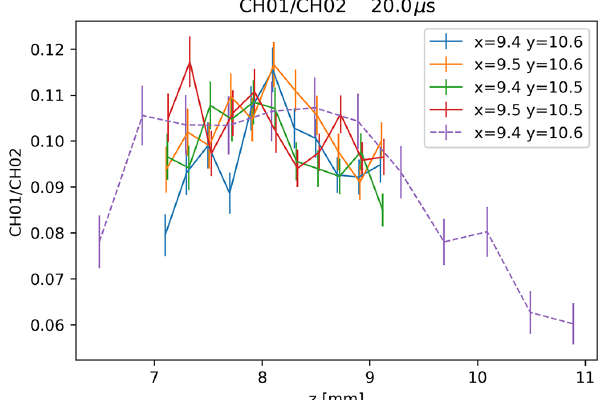
Figure 13. Normalized signal at a chosen range (20µs – 3000m) for different x and y positions as a function of z ; data from both mapping sessions (dashed line for the first session, solid line for the second). A plateau is reached approximately between z = 7mm and z = 9mm. Each colour corresponds to different x and y positions as indicated in the legend of the plot.